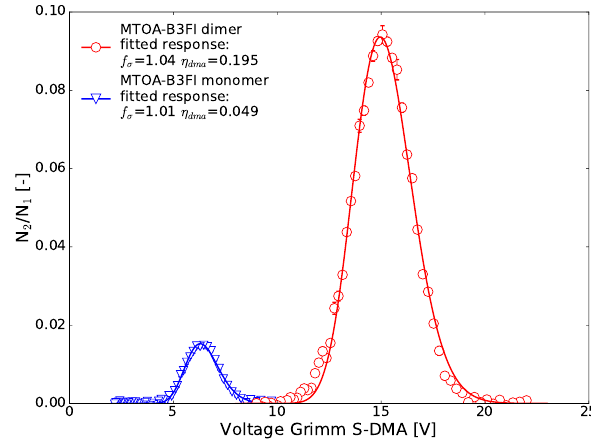
Figure 5. Voltage scan of a Grimm S-DMA while the UDMA is classifying either MTOA-B3FI monomer or dimer. The measure- ments are fitted by the expected response based on Stolzenburg’s diffusive transfer function and two additional free parameters: a penetration efficiency η dma and an additional width parameter f σ . Reported results correspond to DMA serial number